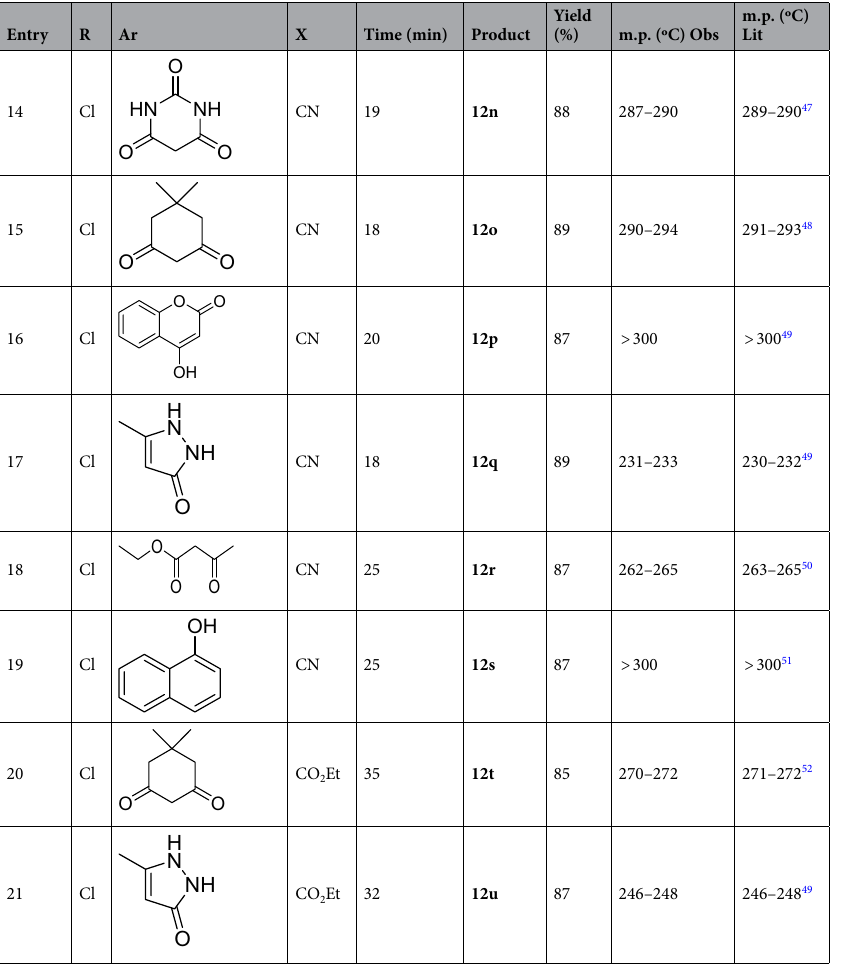
Table 2. Synthesis of spiro-2-amino-4 H -pyrans (spirochromenes) ( 12a-u ) within the presence of biochar/ Fe 3 O4/PVIm/Ag using